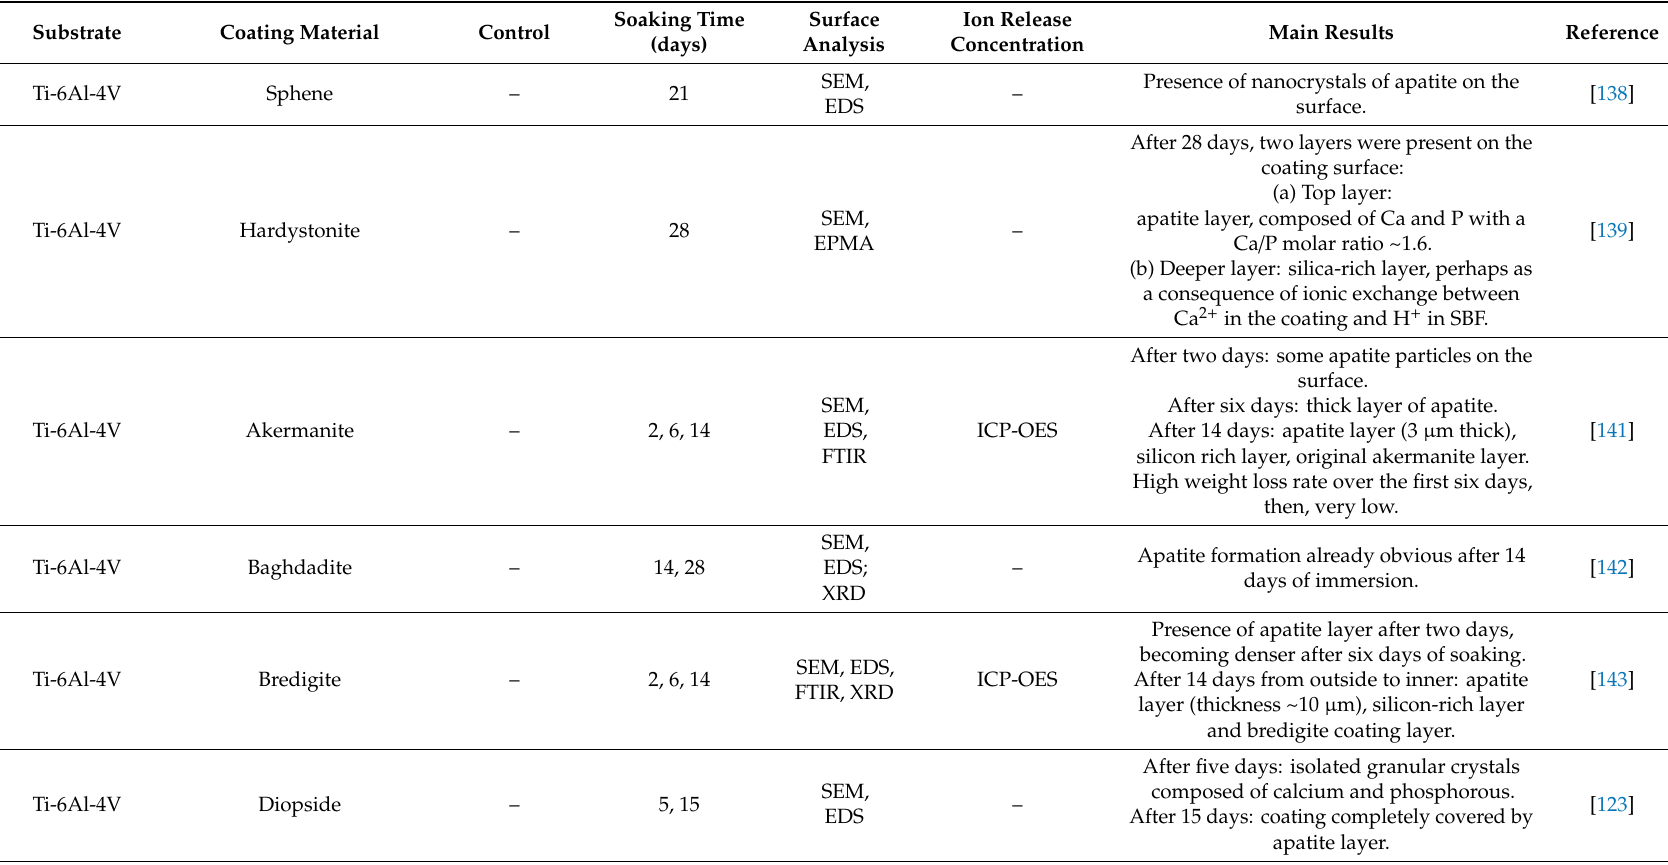
Table 6. In vitro apatite forming ability of the coatings assessed by immersion